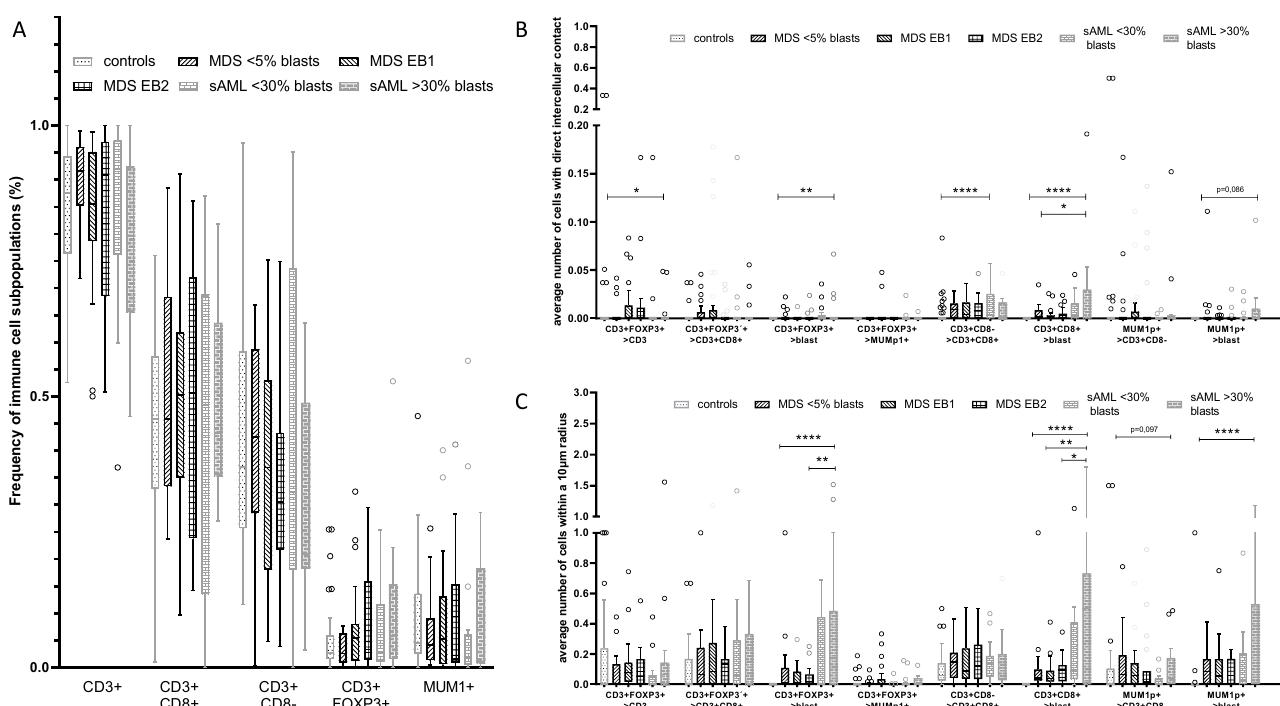
Figure 3. Overall frequency and composition of the immune cell infiltrate with respect to the CD34 + blast cell count in MDS and sAML. ( A ) Determination of the frequency of CD3+ T cells, CD3+CD8+ T cells, CD3+CD8 − T cells, CD3+FOXP3+ T cells and MUM1p+CD3 − B/plasma cells in relation to the total of cells within the BMB demonstrating minor differences within the respective groups. In contrast, the spatial distribution of immune cell subsets in relation to the CD34+ blast frequency in BMBs of MDS and sAML patients compared to controls revealed a significantly elevated frequency of MUM1p+CD3 − B/plasma cells in sAML cases with >30% CD34+ blasts when compared to all other diseased patients. Analysis of the different intercellular distances (categories I–IV) demonstrated the most significant differences within a radius of 10 μ m [II]. Representative data are shown for the parameters direct intercellular contact ( B ) and intercellular distance of 10 μ m ( C ). Statistically significant relations are marked with asterisks (* p < 0.05; ** p <0.005, *** p < 0.0005).